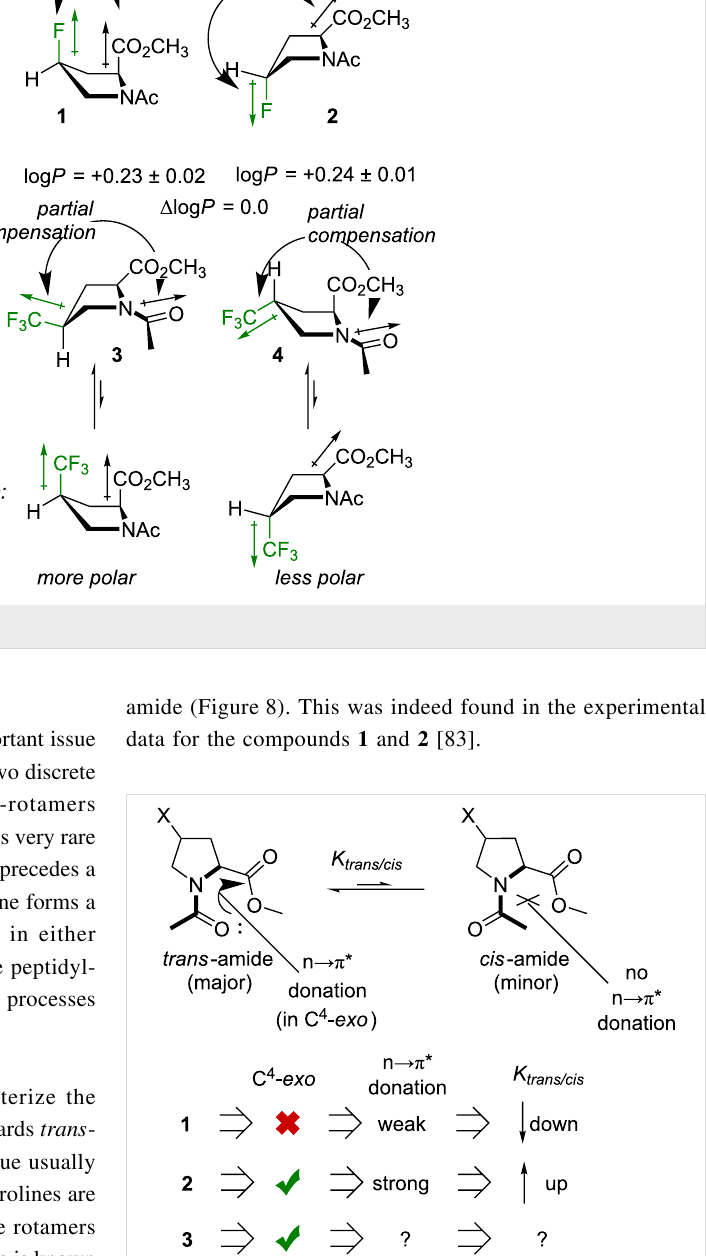
notorious for the relative stabilization of the amide rotamers